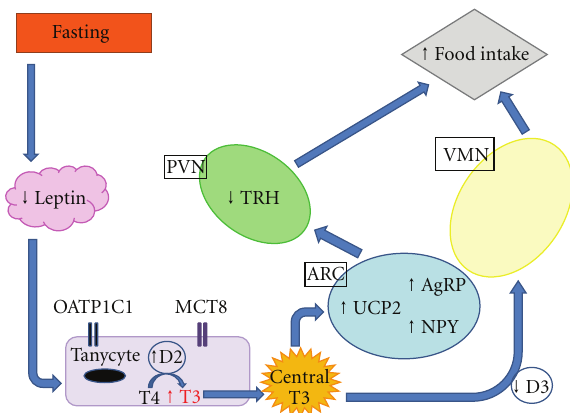
Figure 3: E ff ect and consequences of fasting on central T3 levels, mediated by D2 and D3. PVN: paraventricular nucleus; ARC: arcuate nucleus; VMN: ventromedial nucleus; TRH: thyrotropin releasing hormone; T4: thyroxine; T3: triiodothyronine; OATP1C1: Organic anion transporting polypeptide 1c1; MCT8: monocar- boxylate transporter 8; D2: Deiodinase 2; D3: deiodinase 3; NPY: Neuropeptide Y; AgRP: agouti-related protein; UCP2: uncoupling protein